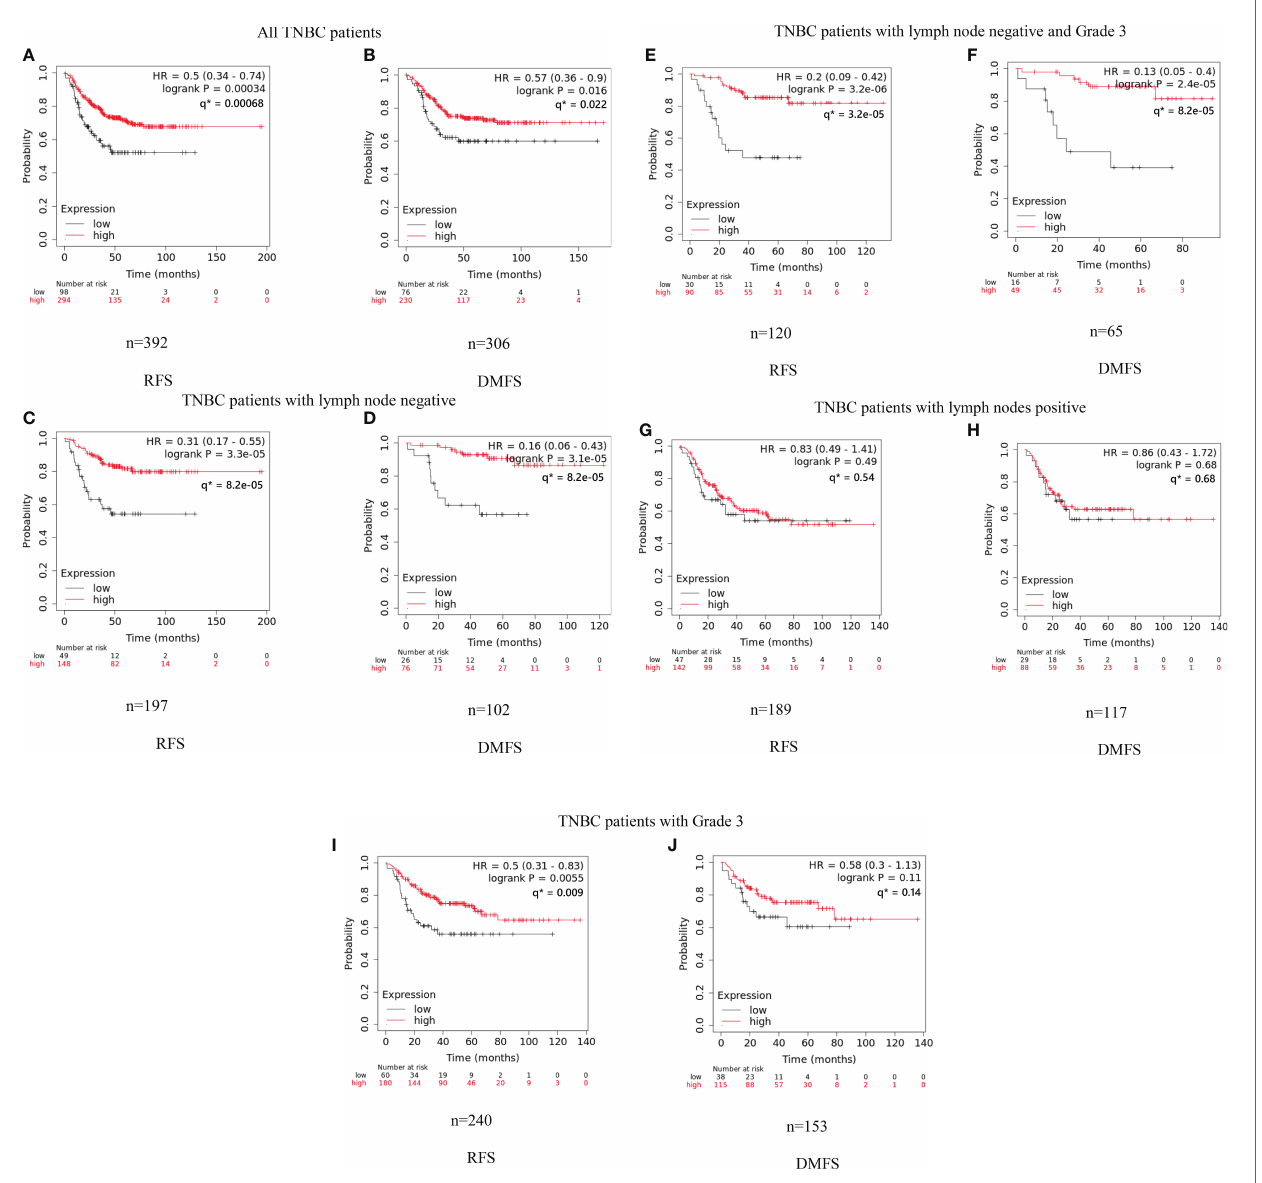
FIGURE 1 | Kaplan – Meier analysis of RFS and DMFS of IGLC2 mRNA expression for TNBC subgroups. We used the KM plotter online cancer survival analysis tool (http://kmplot.com/analysis/) to evaluate the RFS (A, C, E, G, I) and DMFS (B, D, F, H) in TNBC subgroups grouped by grade and lymph node status. The panels (A, B) are all from TNBC patients; (C, D) are TNBC patients developing negative lymph nodes; (E, F) are TNBC patients developing negative lymph nodes and Grade 3; (G, H) are TNBC patients developing positive lymph nodes; (I, J) are TNBC patients developing Grade 3. The lower quartile was set to be the cut-off point of IGLC2 gene expression. Grade 1 and 2 subgroups were not analyzed given the limited sample size (n < 35) for meaningful analysis. Y axis denotes the probability of RFS or DMFS. * q values were calculated using Benjamini-Hochberg